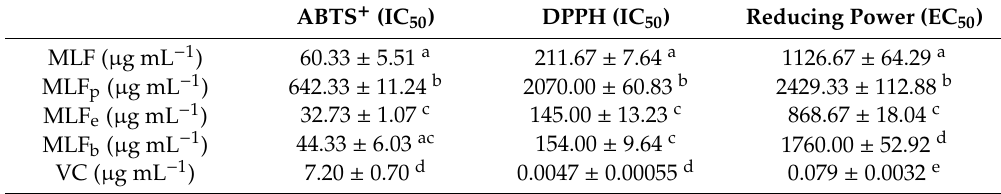
Table 5. The results of antioxidant in vitro of MLF samples and vitamin C